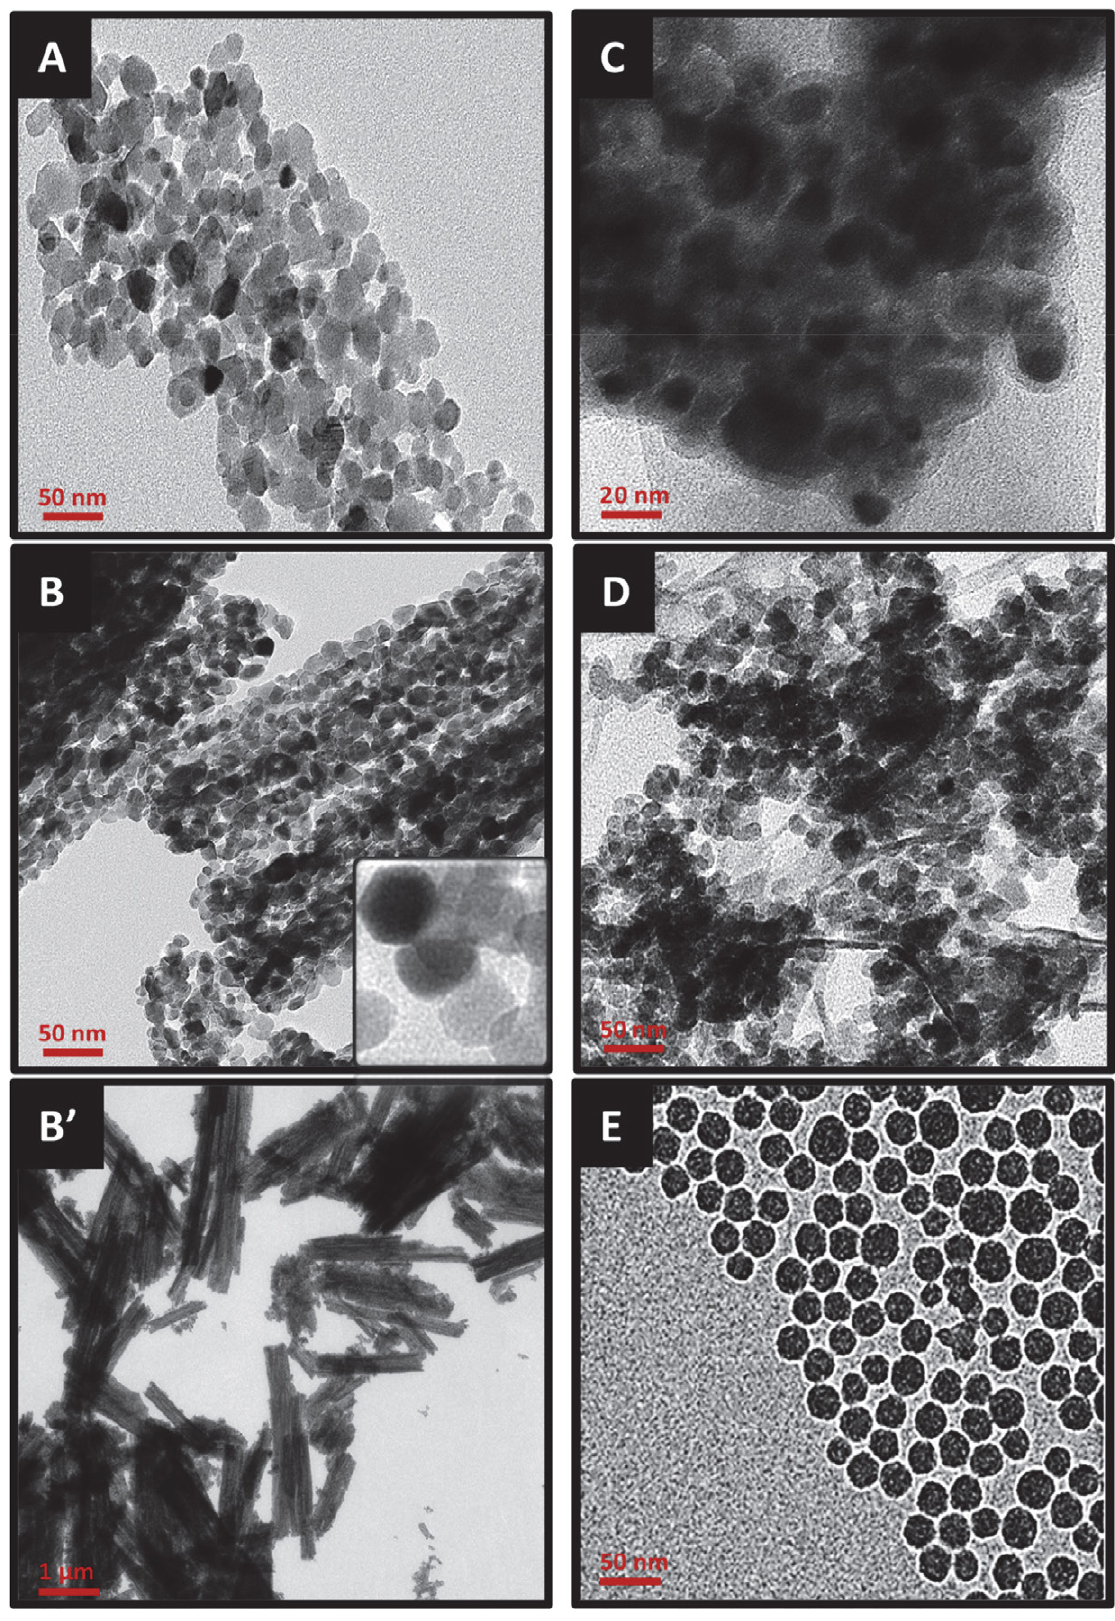
Figure 1: TEM images of (A) ZnO-NPs, (B and B´) different magnifications of ZnO nanocluster bars, (C) ZnO-SiO A , (D) ZnO-SiO B , and (E) SiO 2 NPs,